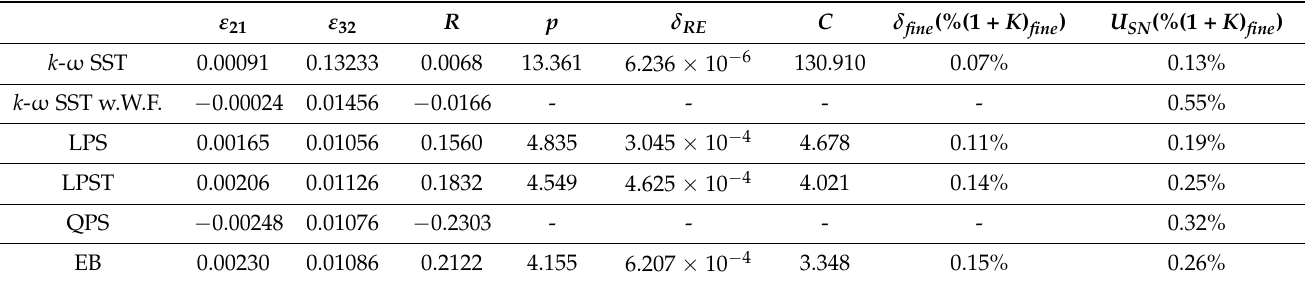
Table 4. Results of the Verification.